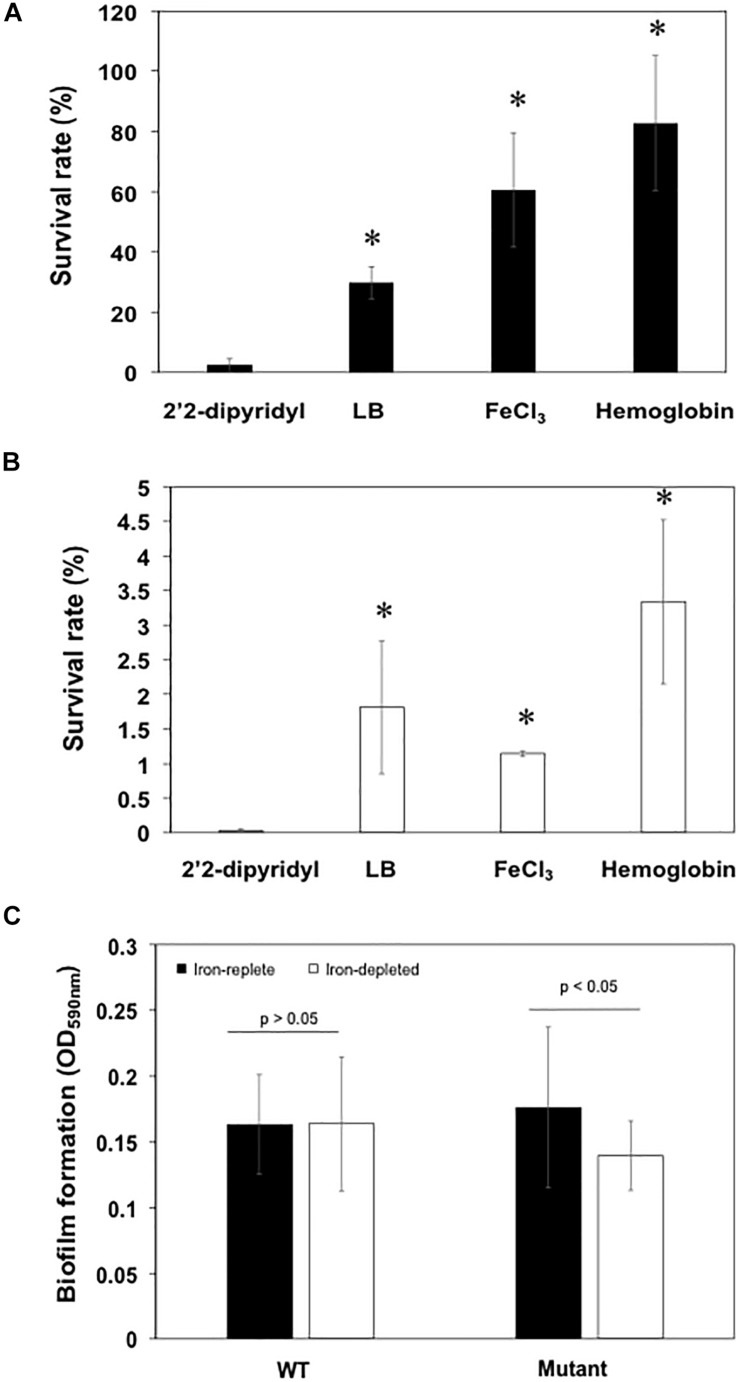
Deficiency in siderophore synthesis was susceptible to H2O2 damage and led to the attenuated biofilm formation. (A) The survival rate of WT cells in low iron media (LB added with 2′2-dipyridyl), LB media, high iron media, and LB media supplemented with hemoglobin. (B) The survival rate of mutants in low iron media (LB added with 2′2-dipyridyl), LB media, high iron media, and LB media supplemented with hemoglobin. (C) Biofilm formation of the WT and mutant cells grown in the low iron and high iron media. Values are means ± standard deviation. Asterisks indicate there was a significant difference (P < 0.05).